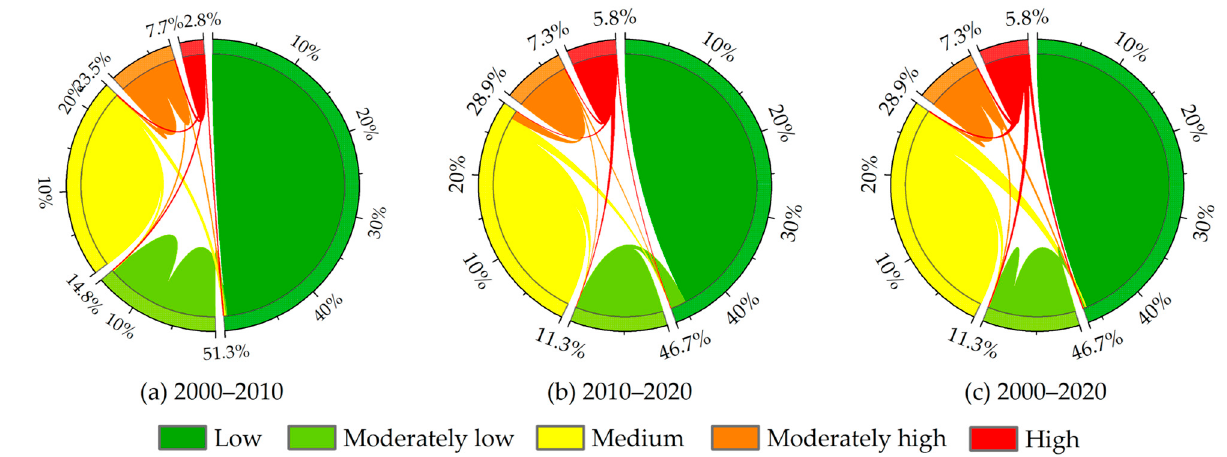
Figure 8. The magnitude of change and flow direction of each grade of human footprint in Guiyang city from 2000 to 2020.